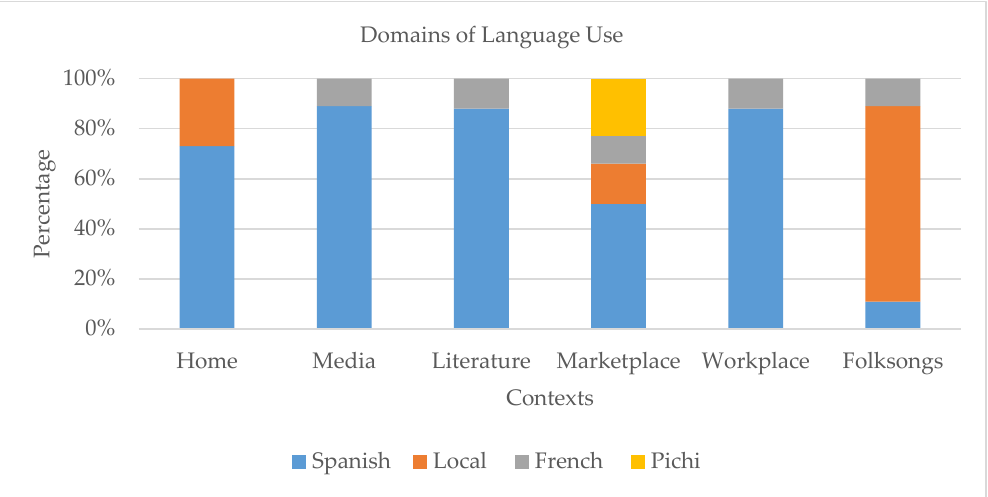
Figure 3. Domains of Language Use.